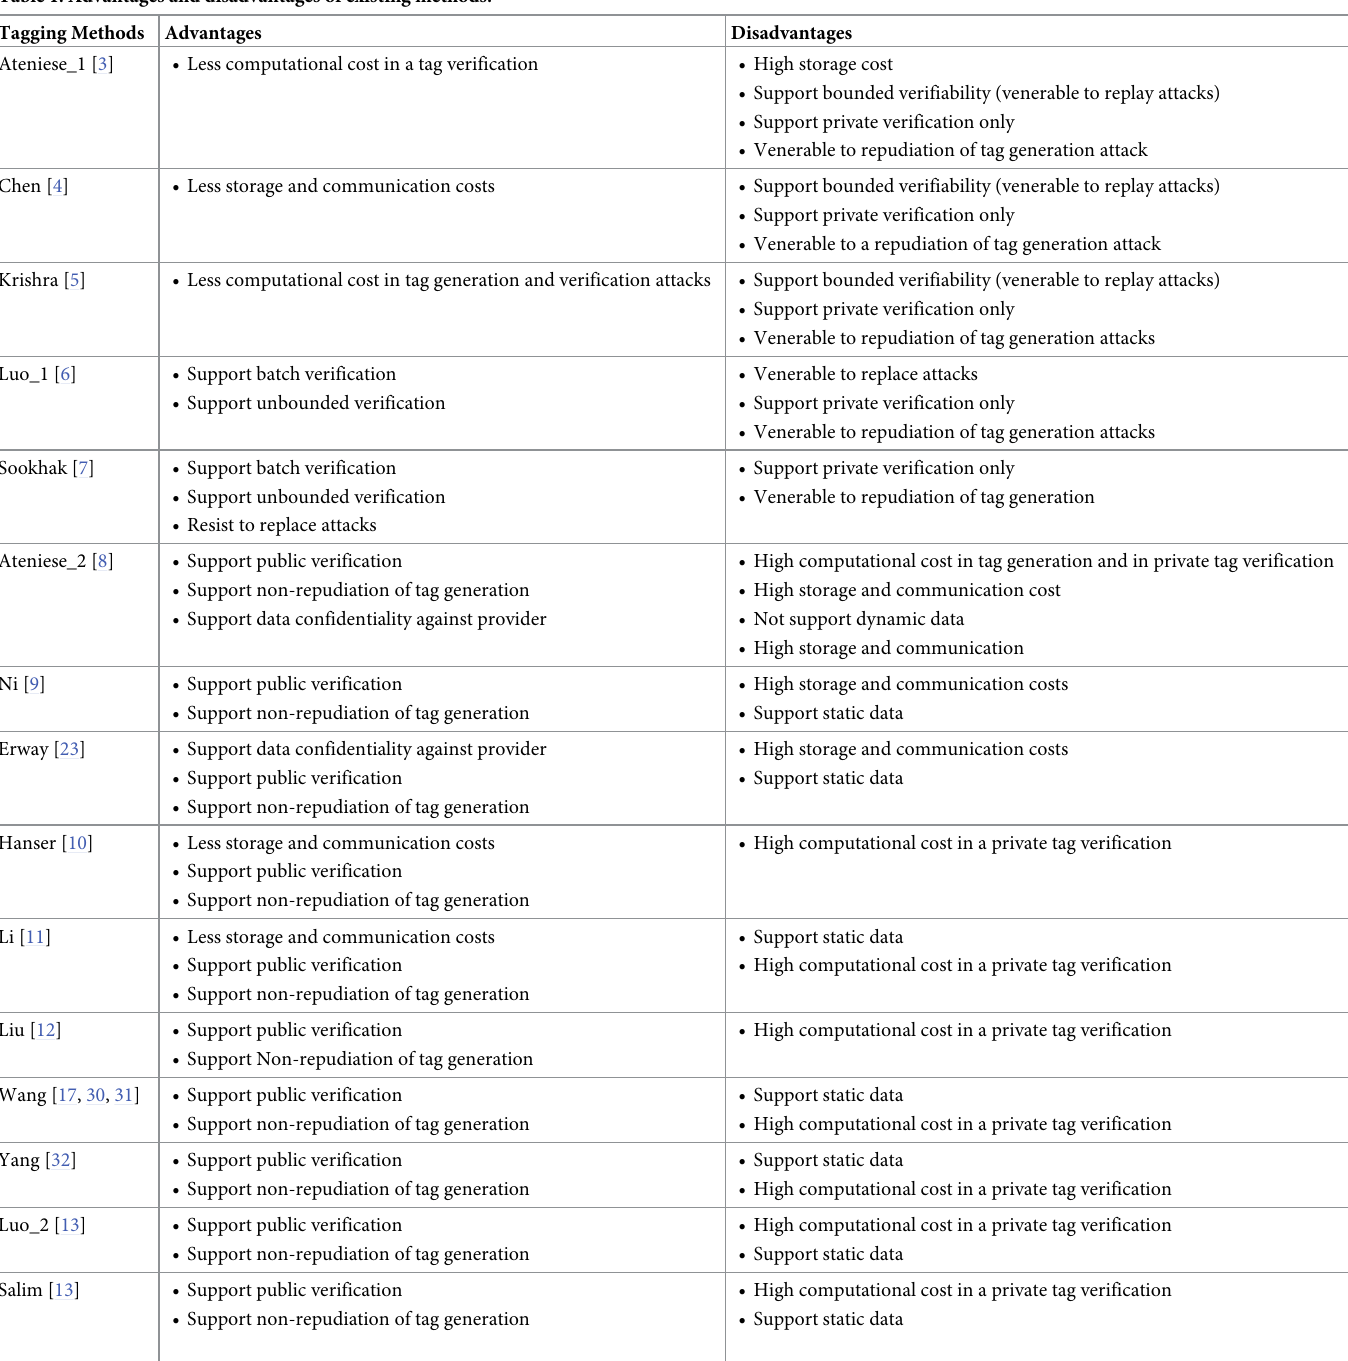
Table 1. Advantages and disadvantages of existing